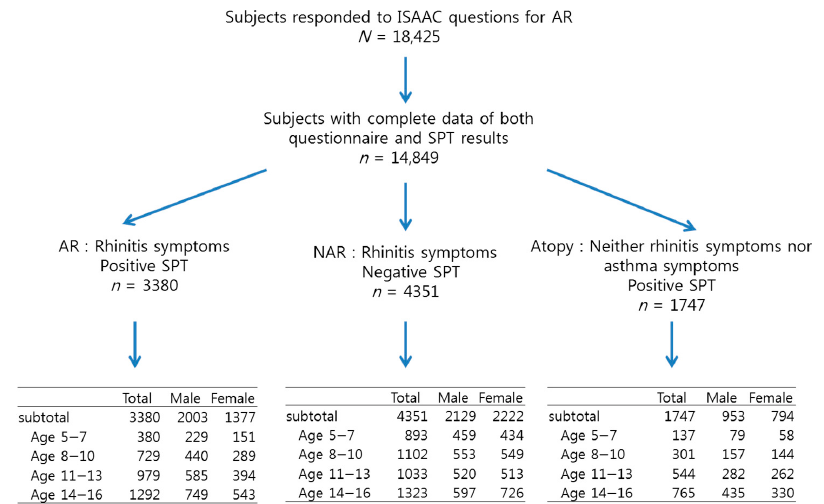
Figure 1. Flowchart of the study participants. Abbreviations: AR, allergic rhinitis; NAR, non-allergic rhinitis; SPT, skin prick test.